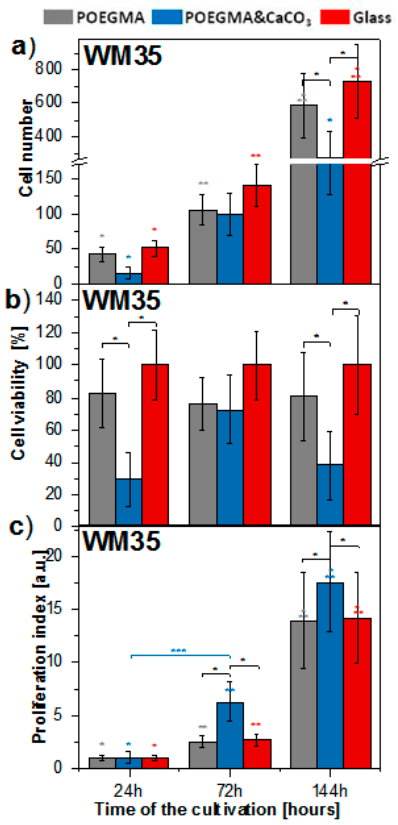
Figure 9. Fluorescence images of cancerous WM35 cells after 24 ( a – c ), 72 ( d – f ) and 144 h ( g – i ) of cultivation on glass surface ( c , f , i ), POEGMA ( a , d , g ) and POEGMA-grafted brush coatings with incorporated CaCO 3 NPs ( b , e , h ).